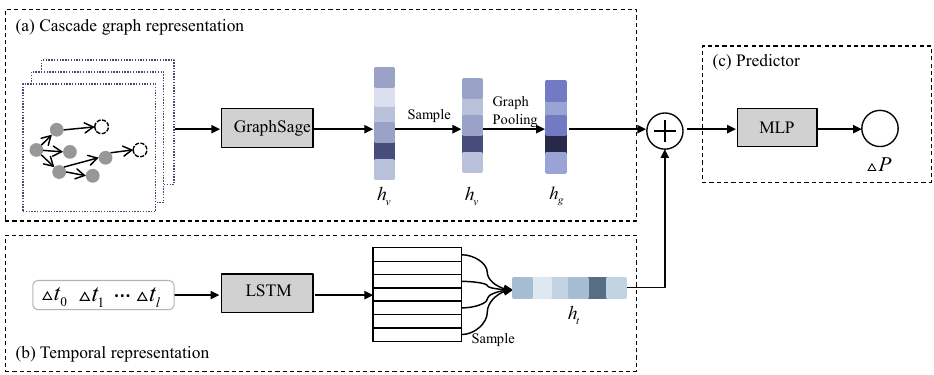
Figure 2. An overview of our proposed model. ( a ) Cascade graph representation: converts cascade graph information into low dimensional representation, i.e., cascade graph representation; ( b ) Tem- poral representation: learns temporal information based on LSTM neural network; ( c ) Predictor: maps cascade graph representation and temporal representation to